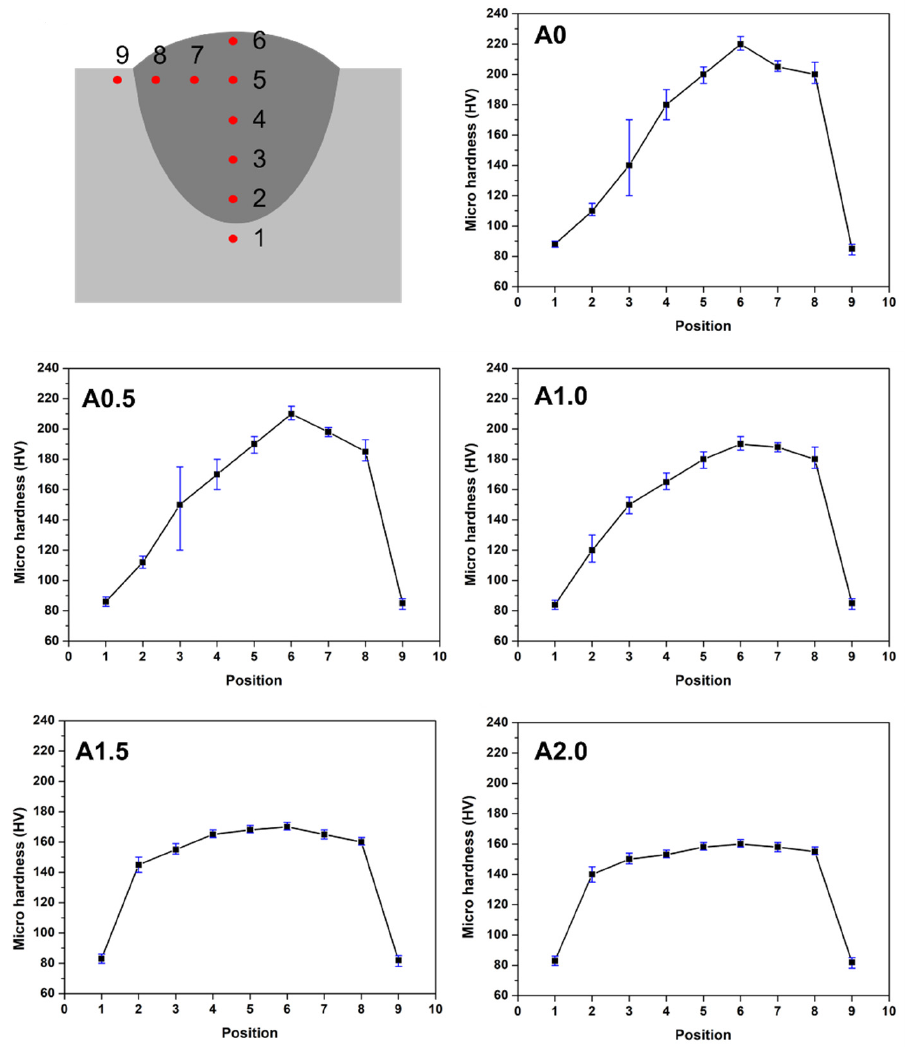
Figure 11. Microhardness of the weld seam cladded with different oscillating